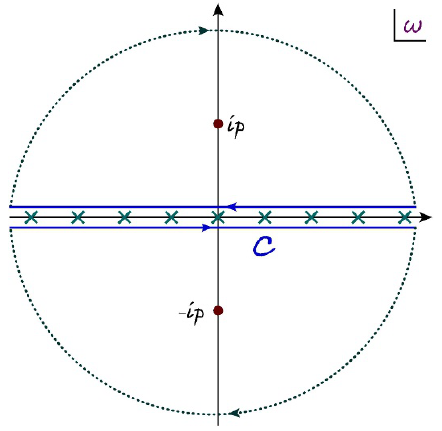
Figure 2. Contours of integration in the complex frequency